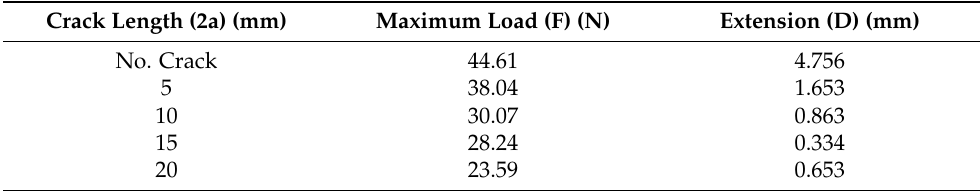
Figure 10. Load vs. displacement of Al foil/Adh/LDPE for 0–20 mm (center cracked). Table 4. Load and displacement of fractured Al foil/Adh/LDPE, thickness B of 45 µ m and dimensions of 230 mm × 95